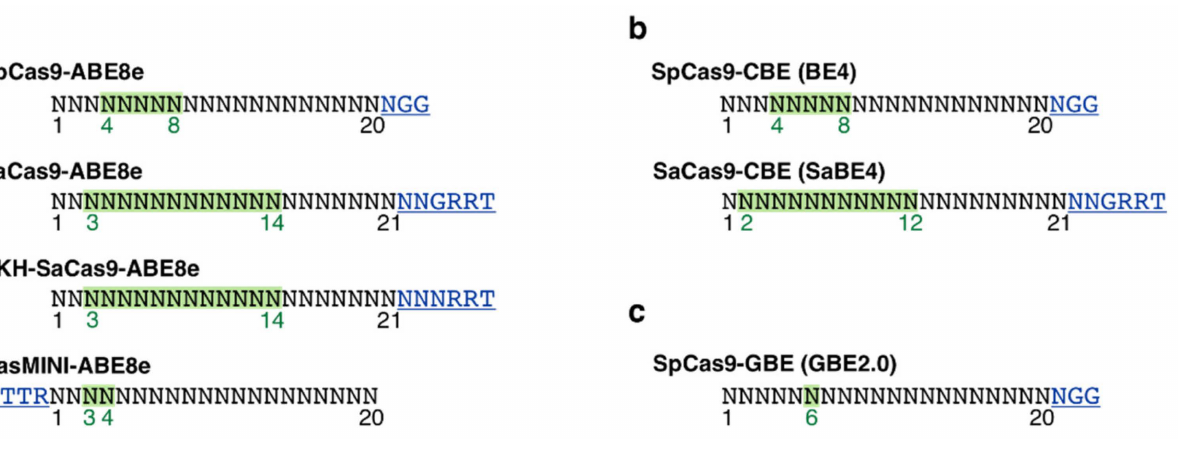
Figure 1. Schematic representation of the ( a ) ABEs, ( b ) CBEs and ( c ) GBEs included in the PAM site analysis and guide RNA design. PAM site requirements (underlined and marked in blue), ideal editing windows (highlighted in green) and optimal guide lengths are construct-specific [24–27]. R =